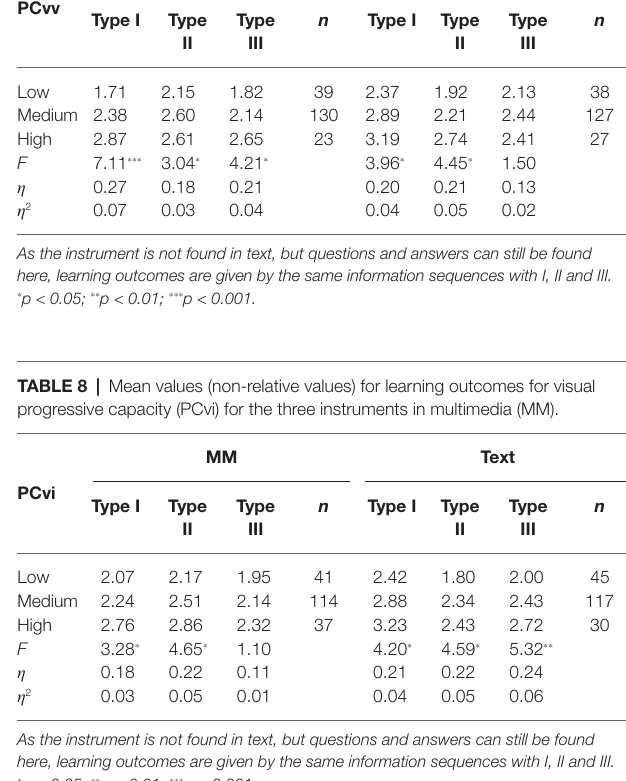
TABLE 7 | Mean values (non-relative values) for learning outcomes for verbal progressive capacity (PCvv) for the three instruments in multimedia (MM). MM Text PCvv